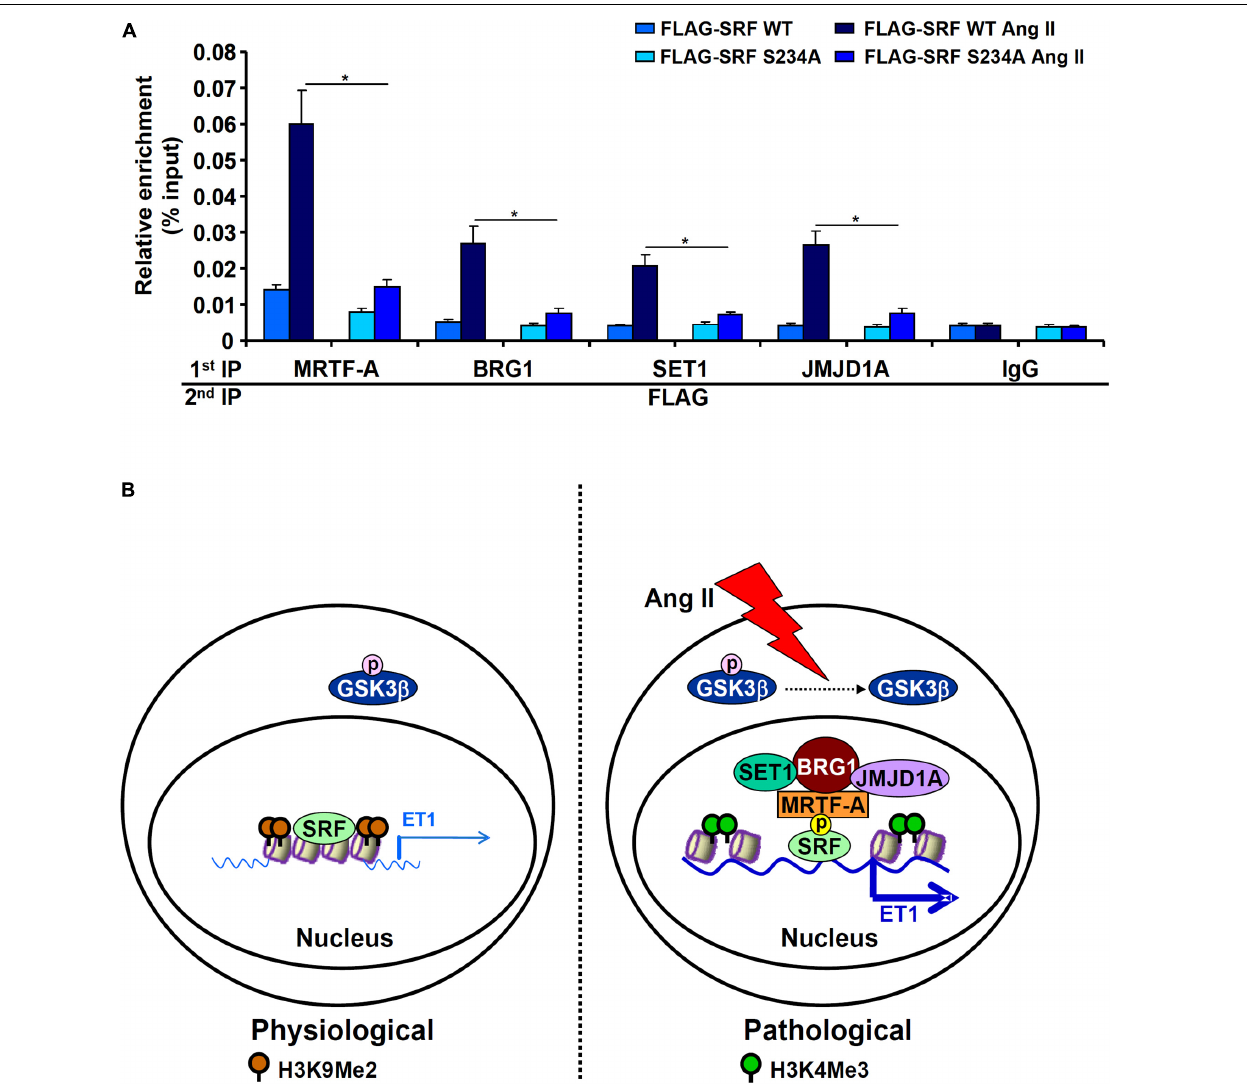
FIGURE 6 | GSK3-mediated SRF phosphorylation licenses the assembly a transcriptional complex to activate endothelin expression. (A) EAhy926 cells were transfected with siRNA targeting SRF followed by transduction with adenoviral SRF expression constructs and treatment with Ang II (0.1 µ M) for 48 h. Re-ChIP assays were performed with indicated antibodies. Error bars represent SD (* p < 0.05, two-way Student’s t -test). All experiments were repeated three times and one representative experiment is shown. (B) A schematic model.